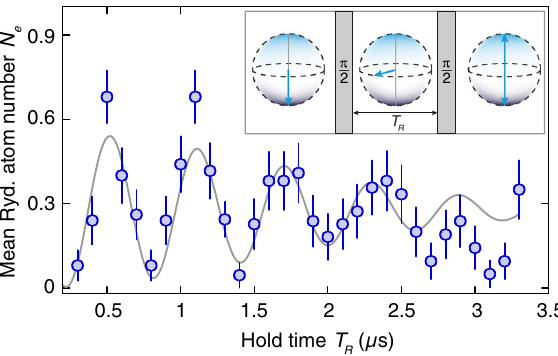
¼ 1 (blue points) and e ¼ 1 subspace e ¼ 2 (field e ¼ 2 events. of all n i;j e